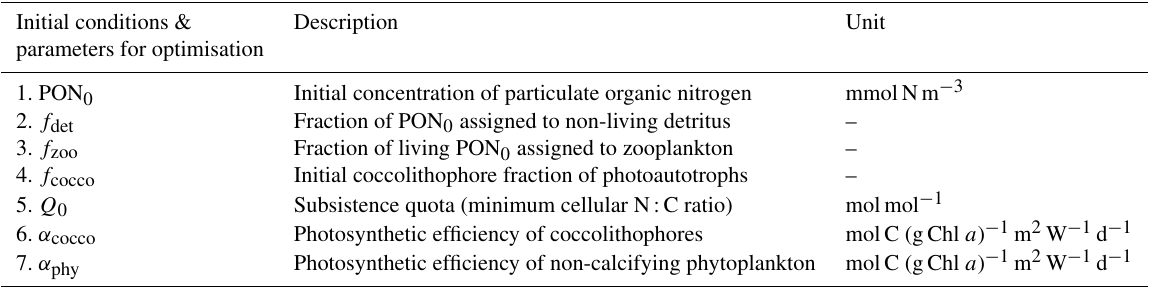
Table 1. Initial conditions and model parameters that are subject to optimisation. Initial conditions & Description